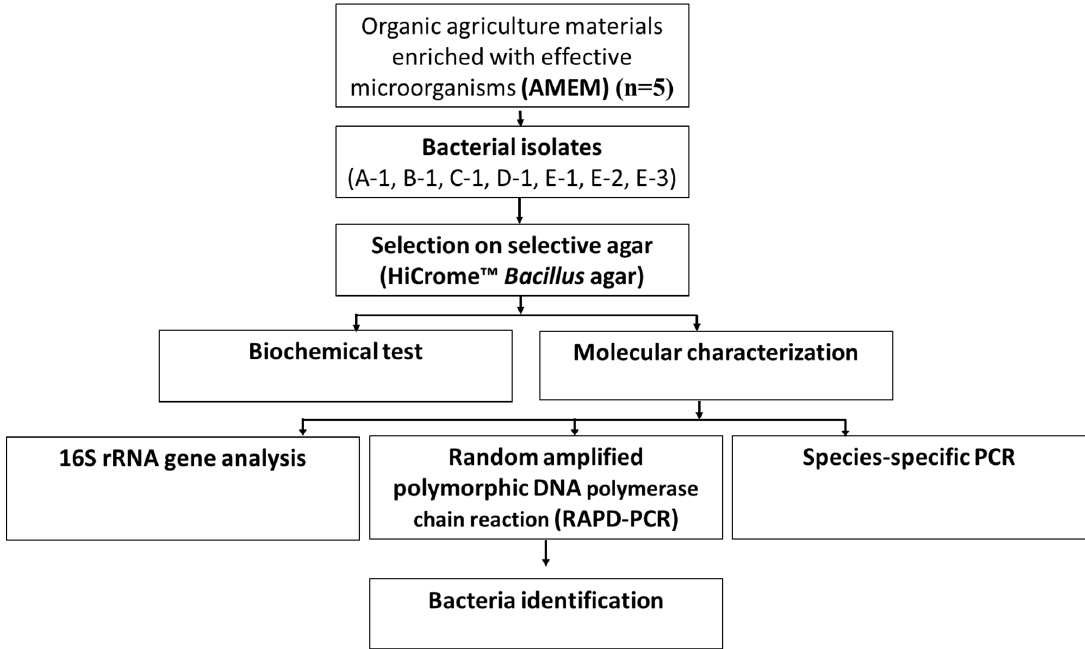
Figure 1. Systemic representation of bacterial identification in commercially available organic agriculture materials enriched with effective